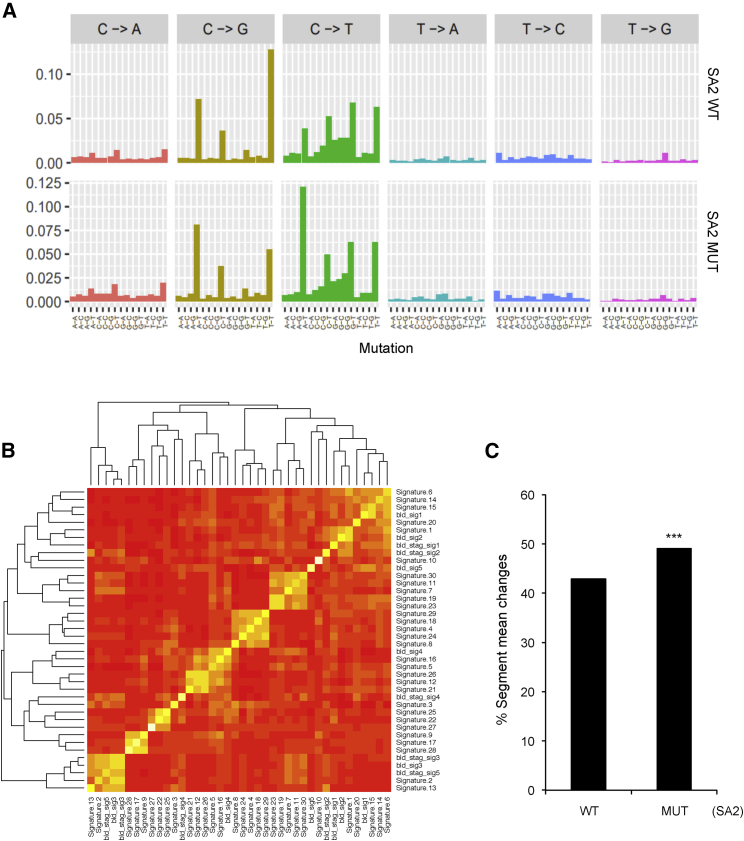
SA2-Deficient Bladder Cancer Samples Show Patterns of Genome Instability that Are Consistent with Loss of Cohesin-Mediated Repair Functions(A) Mutational spectra of all base substitutions observed in SA2-wild-type (top) and SA2 mutant (bottom) bladder cancer samples. Five signatures were identified in each group. See Table S1 for details.(B) Heatmap showing the correlation between the mutational signatures identified in the SA2-stratified bladder cancer samples and those published in COSMIC (Alexandrov et al., 2015). The SA2 mutant cancers (but not the wild-type [WT] bladder cancer samples) had a signature matching COSMIC signature 3, which is annotated as a loss of homologous recombination.(C) Copy-number variation measured as a percentage of segment mean changes present in SA2 mutant or wild-type bladder cancer samples. The SA2 mutant samples had an average of 482 genes with a gain or loss due to copy-number changes, whereas the samples without SA2 mutation had an average of 310. The null hypothesis was that the mutation status of SA2 was independent of the number of genes that had a changed segment mean. ∗∗∗p < 0.001 using chi-squared test.See also Table S1.